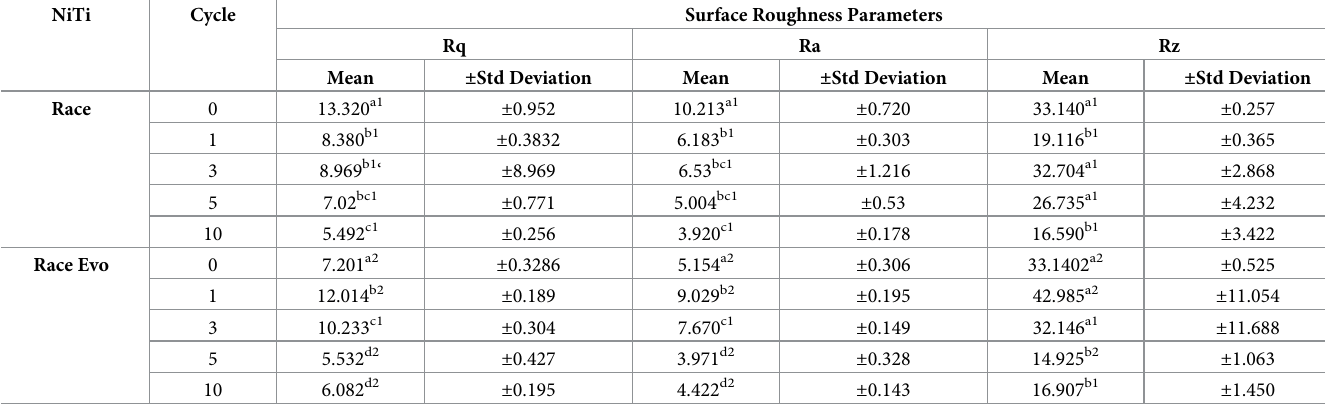
Similar letters indicate non-significant values comparing autoclaving cycles within one group of NiTi files. Similar numbers indicate non-significant values comparing Race and Race Evo files in every autoclaving subgroup. Statistical significance was set at p �